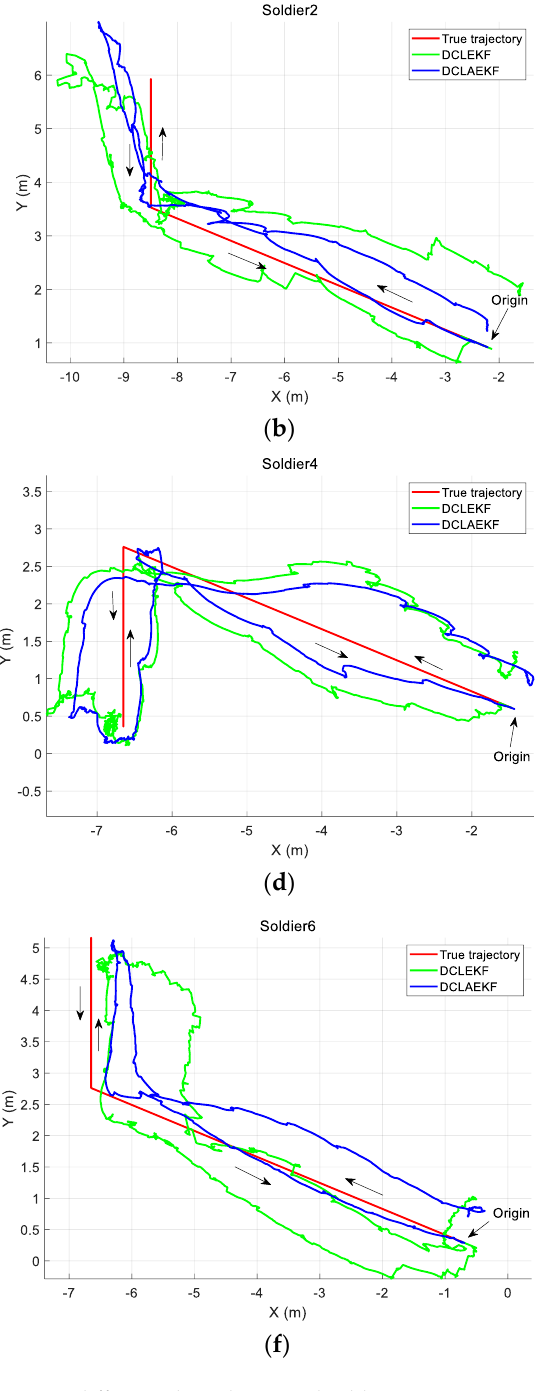
Figure 6. Reference track diagram in the building environment.